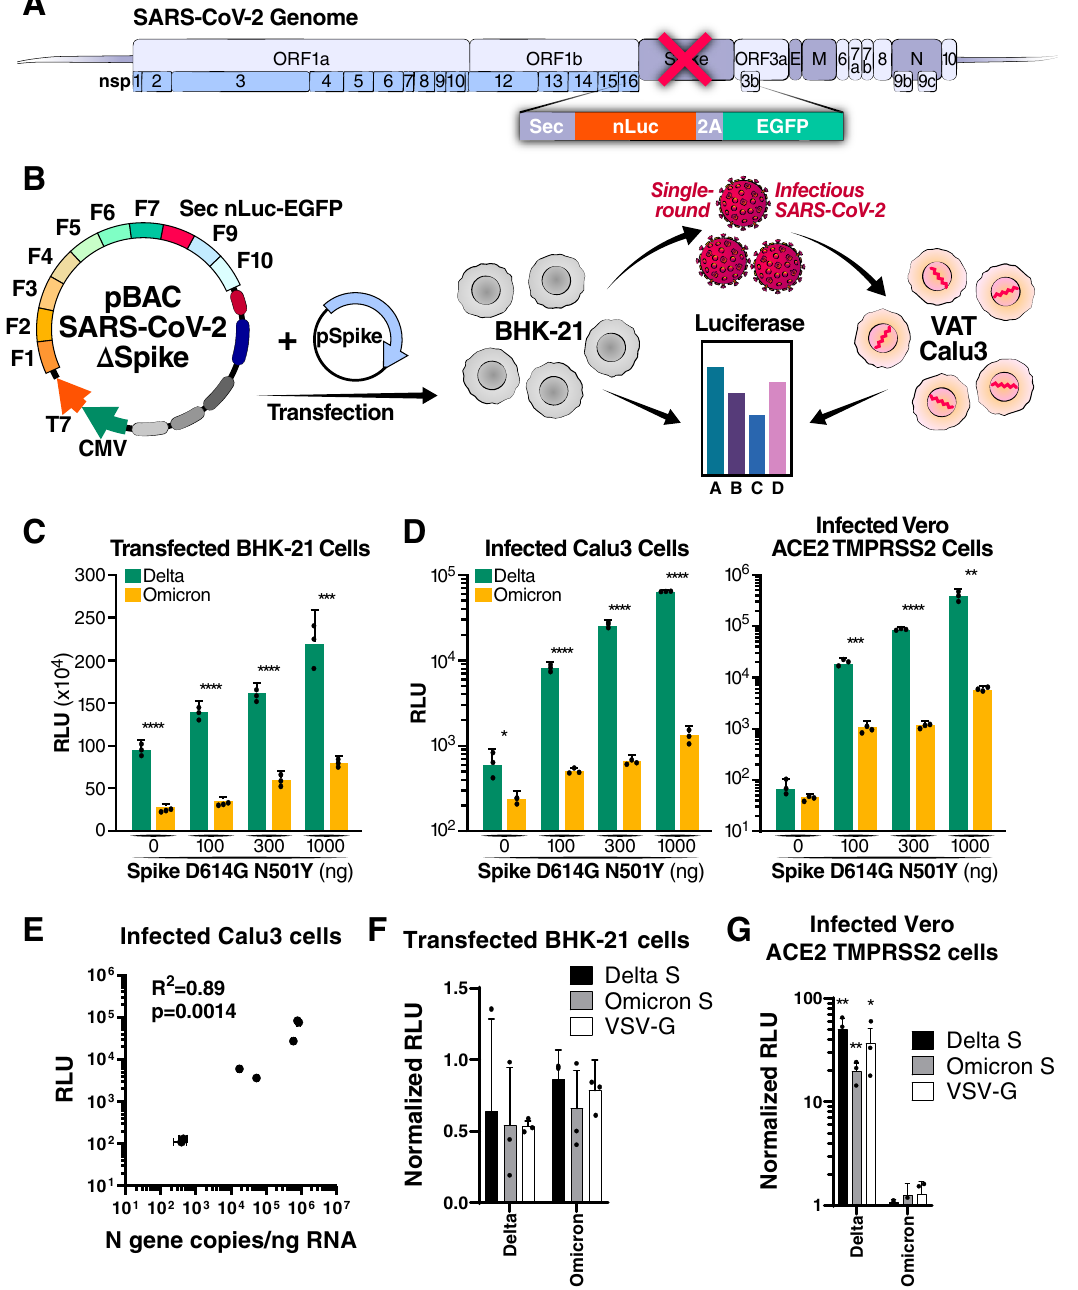
Fig. 4 | Omicron mutations attenuate viral replication independent of Spike. A Schematic of the replicon system in which the Spike gene was replaced with secretedNanoluciferase(SecnLuc)andenhancedgreen fl uorescentprotein(EGFP) separated by a self-cleaving P2A peptide. B Experimental work fl ow of the SARS- CoV-2 replicon assay. VAT, Vero cells stably overexpressing ACE2 and TMPRSS2. C Luciferase readout from cells transfected with increasing amounts of Spike expression construct paired with either the Delta or Omicron replicon plasmids. Averageofthreeindependentexperimentsanalyzedinduplicate±SDandpairwise comparisonsbetweentheDeltaandOmicronvariantsbytwo-sidedStudent ’ s T -test are shown. D Luciferase readout from Calu3 or Vero ACE2 TMPRSS2 cells infected with supernatant from BHK-21cellstransfected with Delta or Omicron replicons in B.Shownaretheaverageofthreeindependentexperimentsanalyzedinduplicate± SDandpairwisecomparisonsbetweentheDeltaandOmicronvariantsbytwo-sided